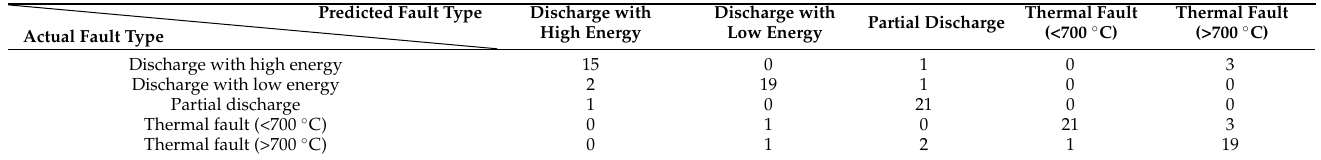
Table 6. Confusion matrix of the AdaBoost